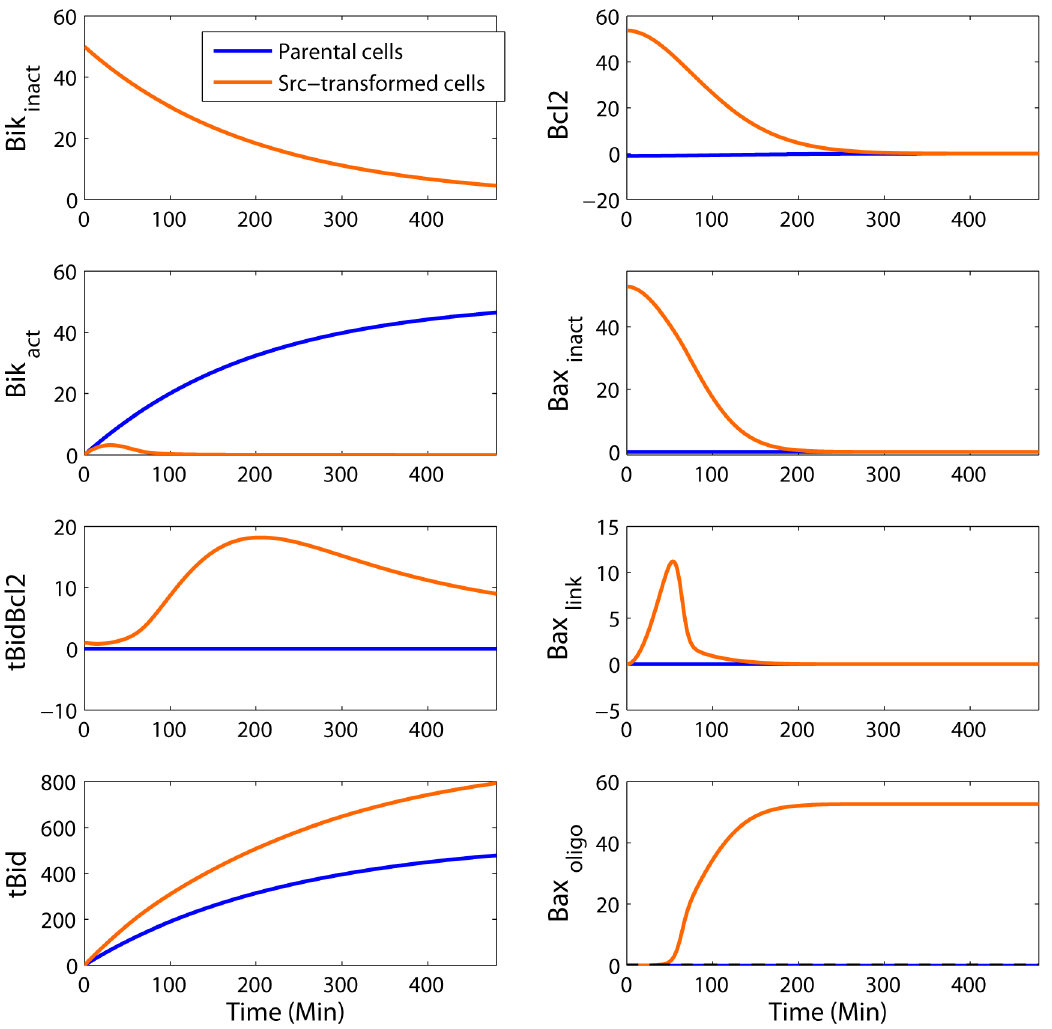
Figure 9. Simulated molecular response to the optimal therapeutic strategy in parental (blue) and Src-transformed (orange) NIH- 3T3 cells. The optimal strategy consisted of exposing cells to staurosporine after exposure to four chemicals: an Src inhibitor, which annihilates Bik Src-dependent ubiquitylation in cancer cells, a Bax inhibitor such that Bax quantity is lower than the apoptotic threshold in normal cells, a Bcl2 inhibitor and an agent which enhances Bid transcription. Under this therapeutic strategy, Bax oligo remained under the apoptotic threshold in normal cells and exceeded it in cancer cells. Time is expressed in min and concentrations in nM.